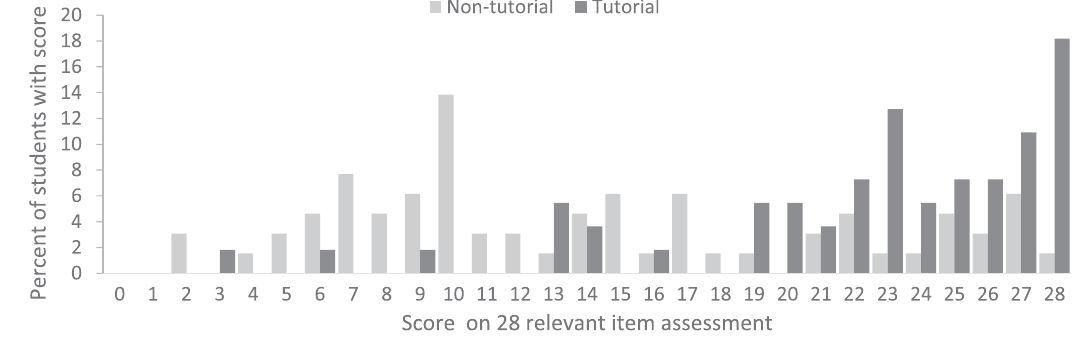
FIG. 5. Distribution of scores for the tutorial and nontutorial groups on the 28 items relevant to the tutorial. The percentages are based on the students within each treatment.